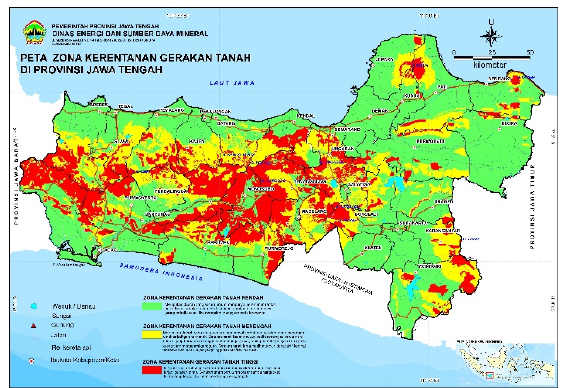
Figure 1. Map of mass movement prone zone in Central java © Department of Energy and Mineral Resources (ESDM) of